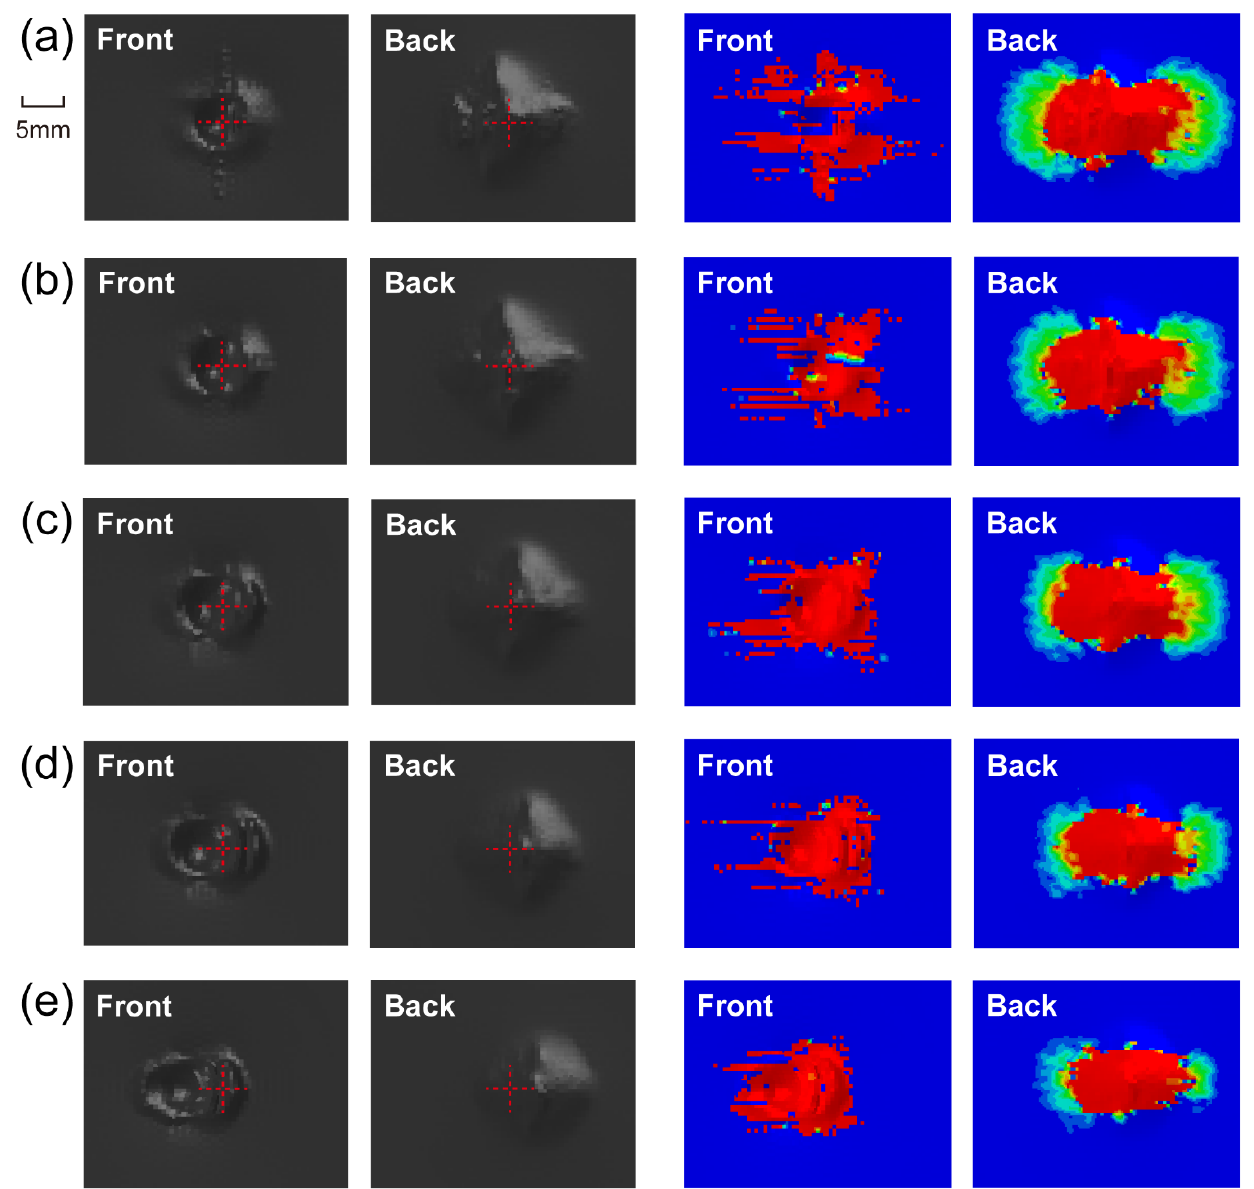
Figure 5. Damage morphology and matrix damage on both sides of laminate with ( a ) 0°, ( b ) 15°, ( c ) 30°, ( d ) 45°, and ( e ) 60° impact angles under 20 J impact energy.